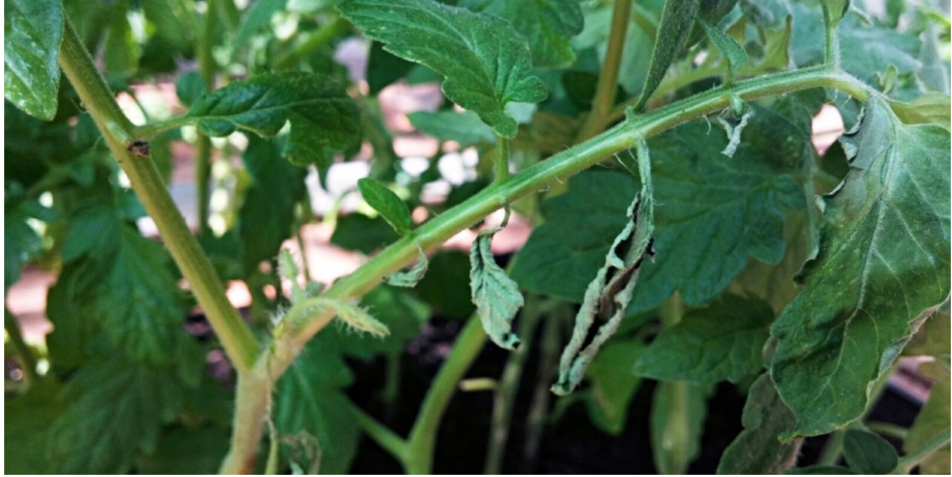
Figure 7. Initial symptoms of bacterial canker caused by Clavibacter michiganensis subsp. michiganensis